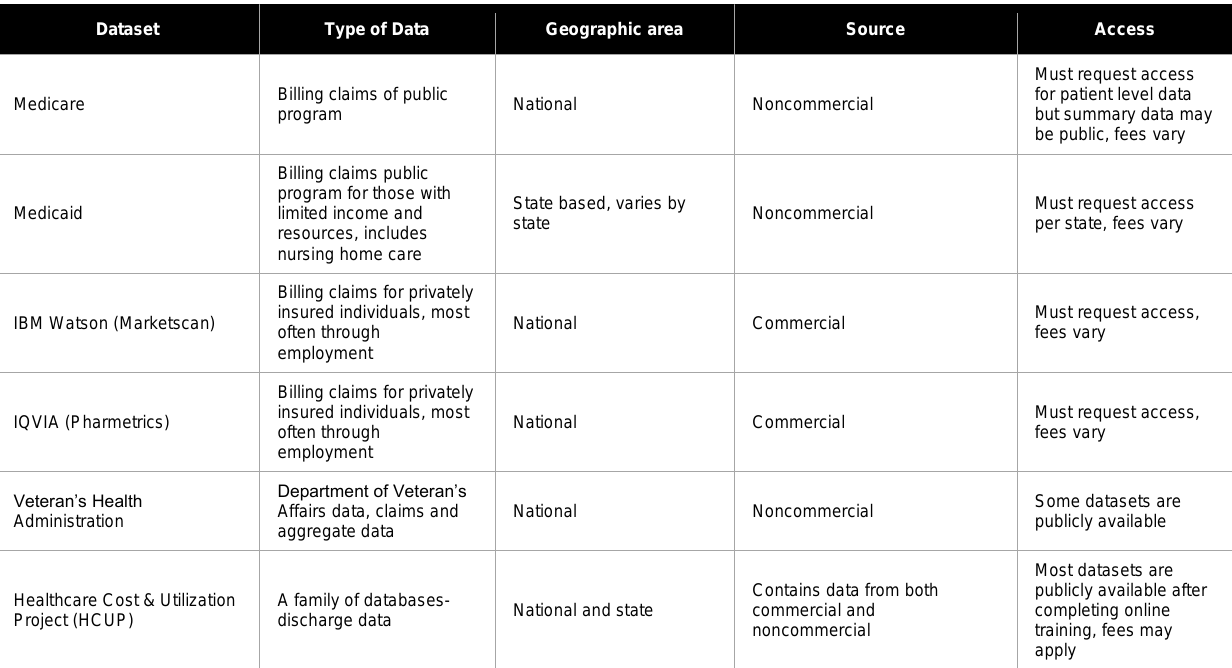
Table 1: Databases that contain prosthetic and orthotic services and/or patients that may require prosthetic or orthotic devices based on individual condition.